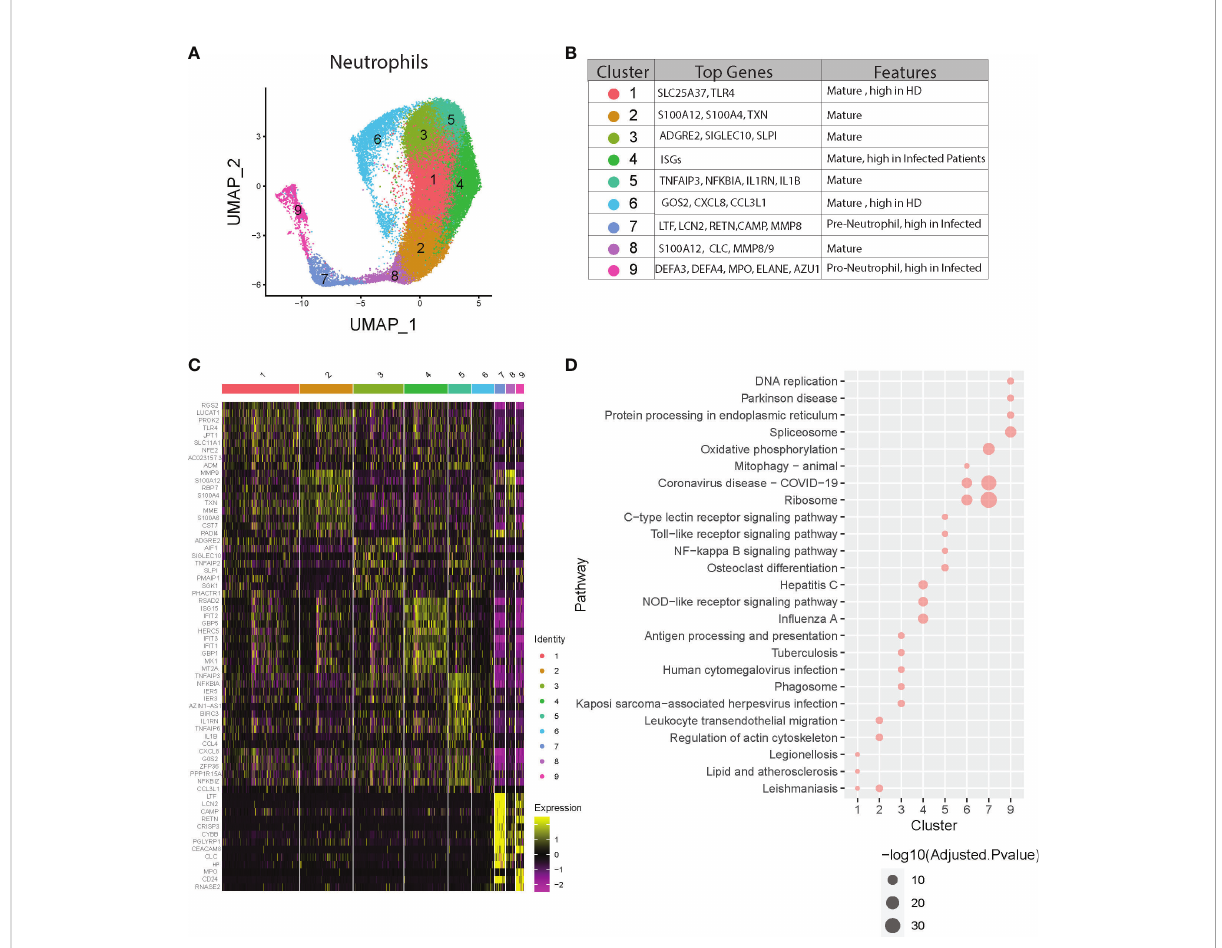
FIGURE 4 Neutrophil heterogeneity in COVID-19 patients. (A) UMAP plot of neutrophil clusters. (B) Nomenclature and marker genes for each neutrophil cluster. (C) Top5 up-regulated genes in every neutrophil cluster. (D) Top3 KEGG pathways signi fi cantly enriched in up-regulated genes in every neutrophil